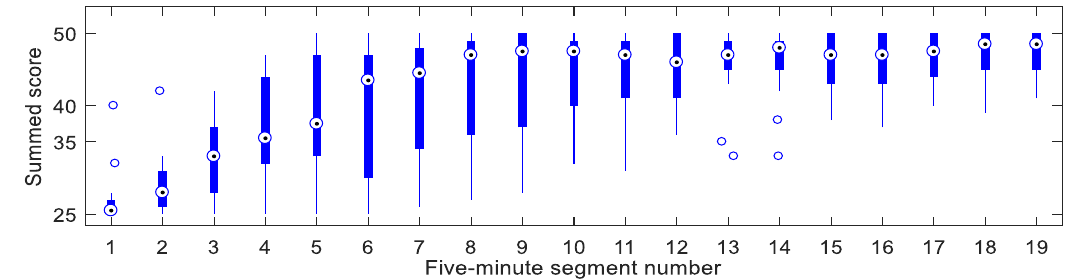
Figure 2. Boxplot of the summed scores of all subjects in 19 five-minute segments.